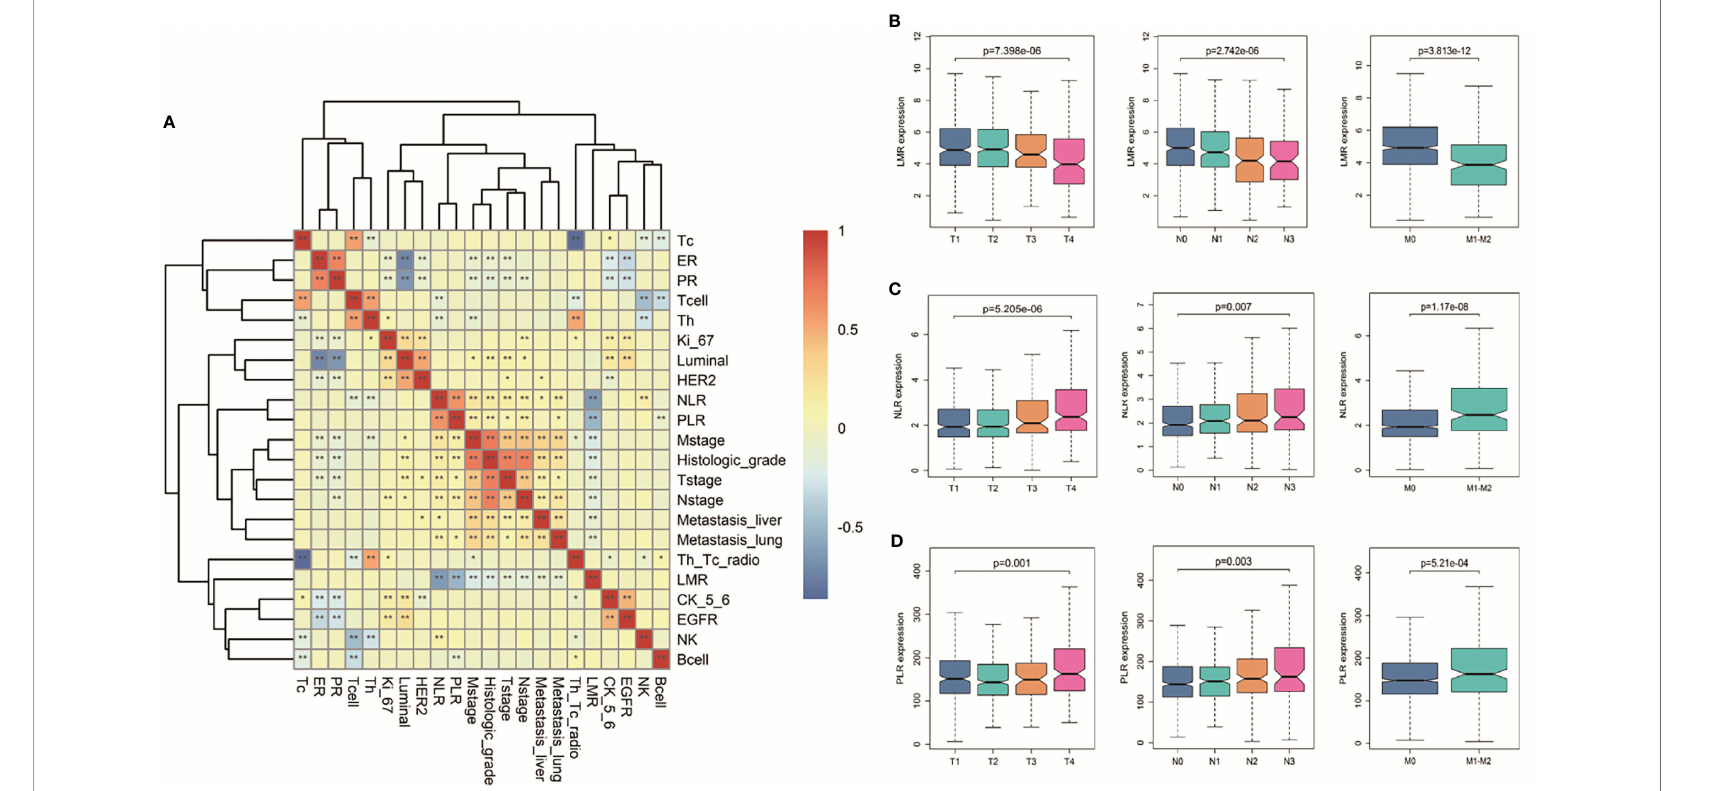
FIGURE 3 | Correlation between clinical indicators and hematological indicators. (A) The heat map of the correlation between clinical indicators and hematological indicators in BC. Different colors in the fi gure correspond to different correlation coef fi cients, and different signi fi cance levels are marked as *P < 0.05, **P < 0.01. (B) Boxplots of the signi fi cantly reduced LMR in the clinical TNM stage. Boxplots of elevated (C) NLR and (D) PLR in the clinical TNM setting. Differences between groups were estimated using the Kruskal – Wallis